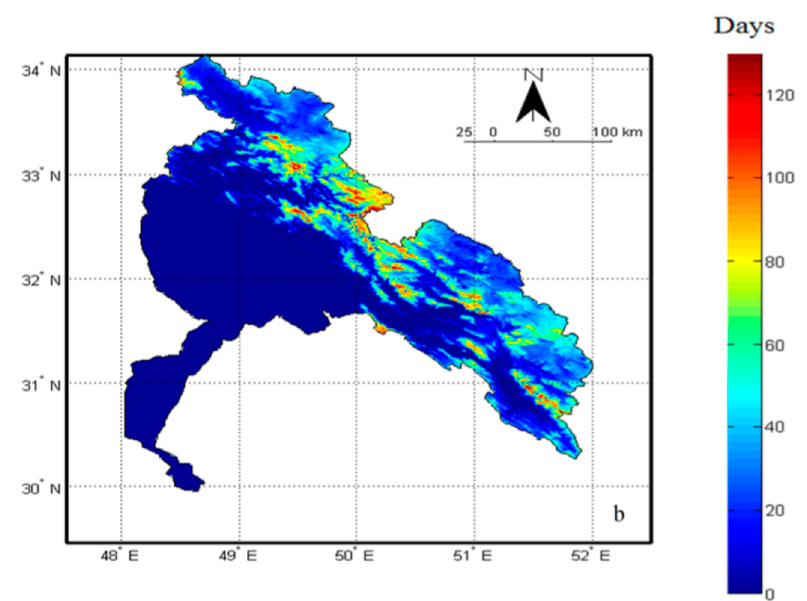
Figure 3. Mean annual land surface temperature (LST) based on MOD11A1 (2003–2015) ( a ). Mean annual snow-covered days (SCD) (days) across the basin based on MOYD (2003–2015) ( b ).